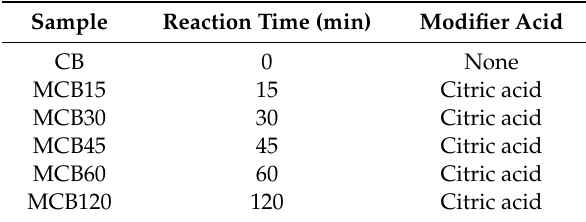
Table 1. Identification of the samples according to the treatment time.